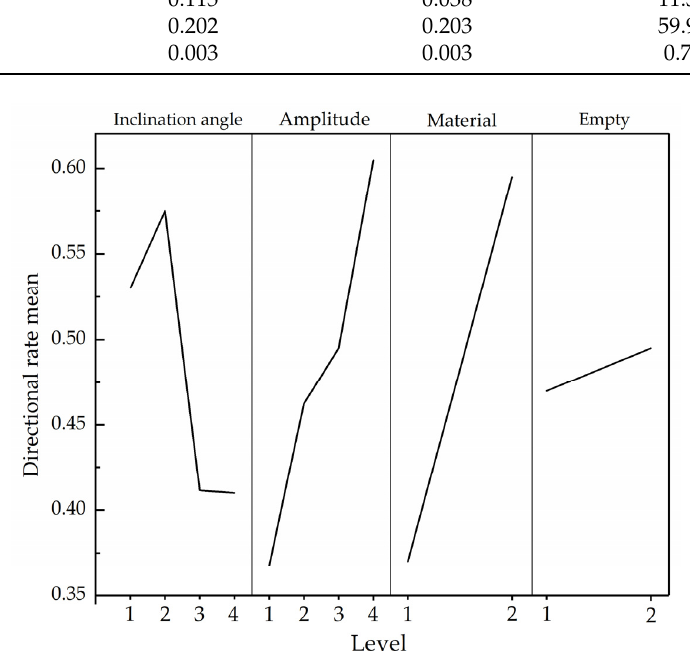
Figure 10. Factor level effect map.